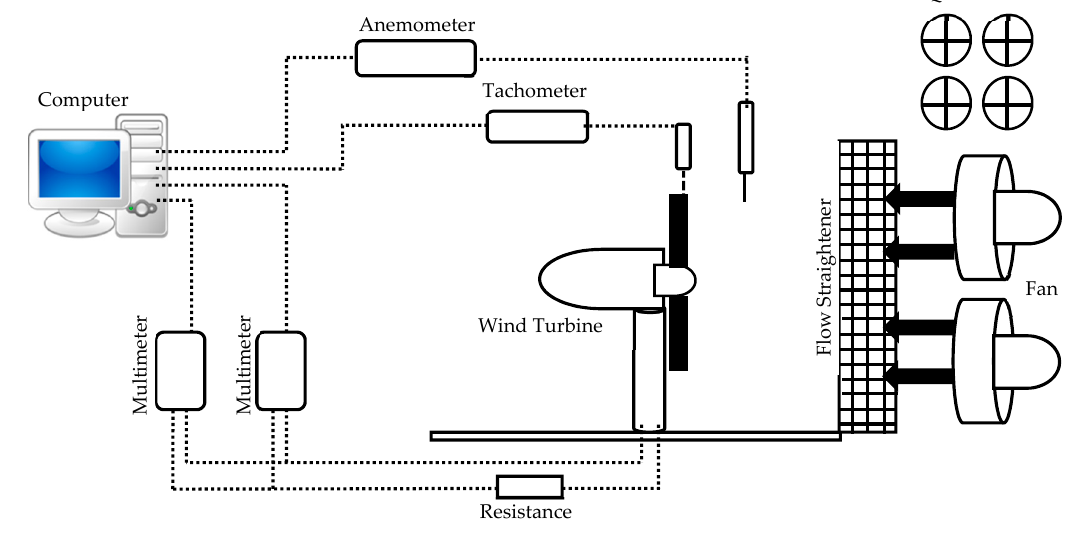
Figure 4. Experimental setup.